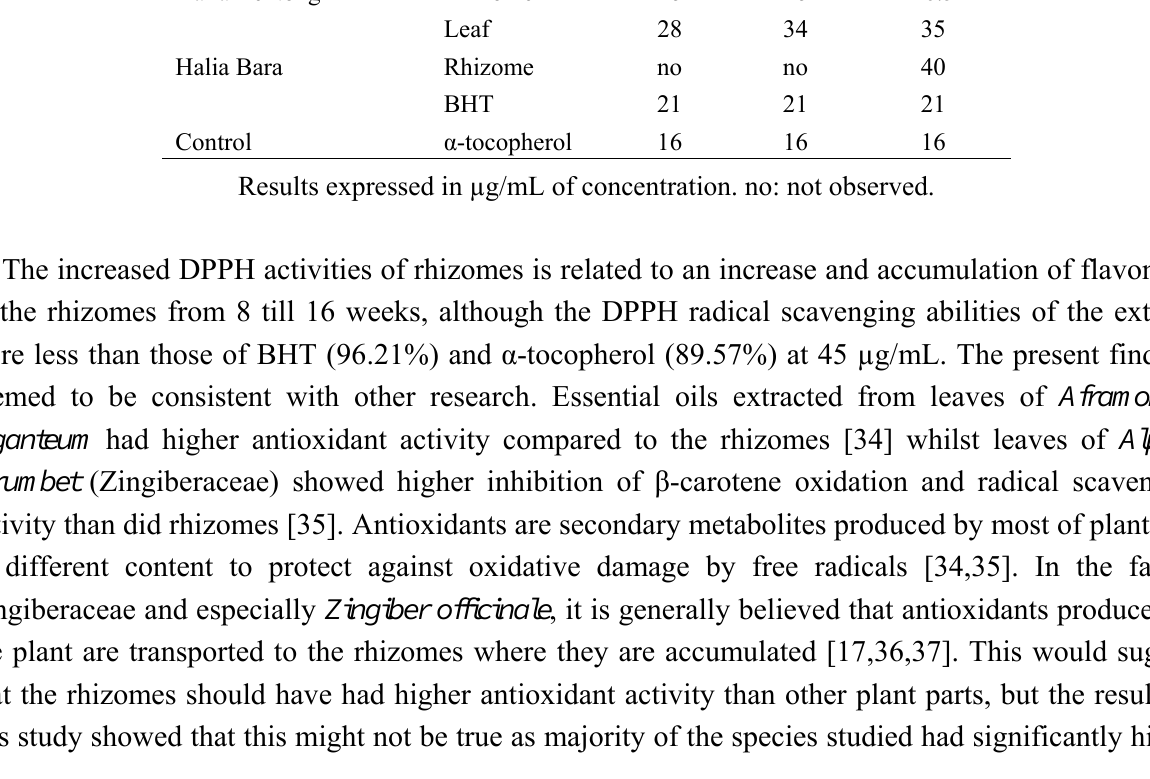
values of ginger ( Zingiber officinale ) extracts in the DPPH assay. Table 4. IC 50 Extraction Variety source Leaf